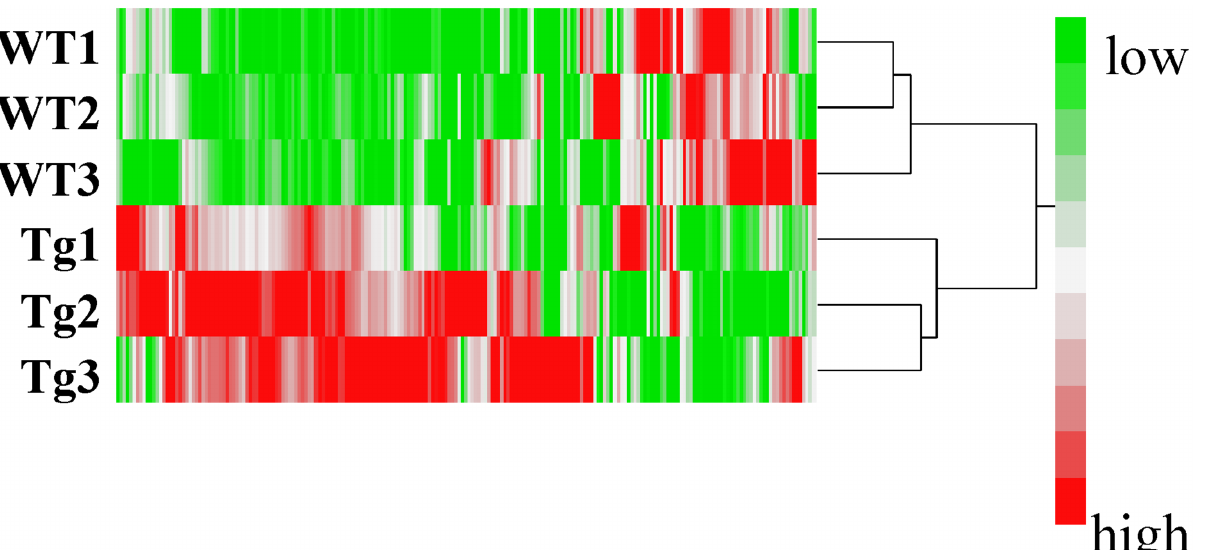
Fig 2. A heat map of hierarchical cluster analysis comparing the metabolite changes between PGC-1 α -Tg mice and WT mice. Horizontal axis shows sample names corresponding to the samples used in Fig 1 (WT1, WT2, and WT3 for wild-type and Tg1, Tg2, and Tg3 for PGC-1 α -Tg mice). The heat map patterns between WT (upper three lanes) and PGC-1 α -Tg (lower three lanes) are clearly distinguishable. The color red demonstrates that the relative content of metabolites is high and green demonstrates that they are